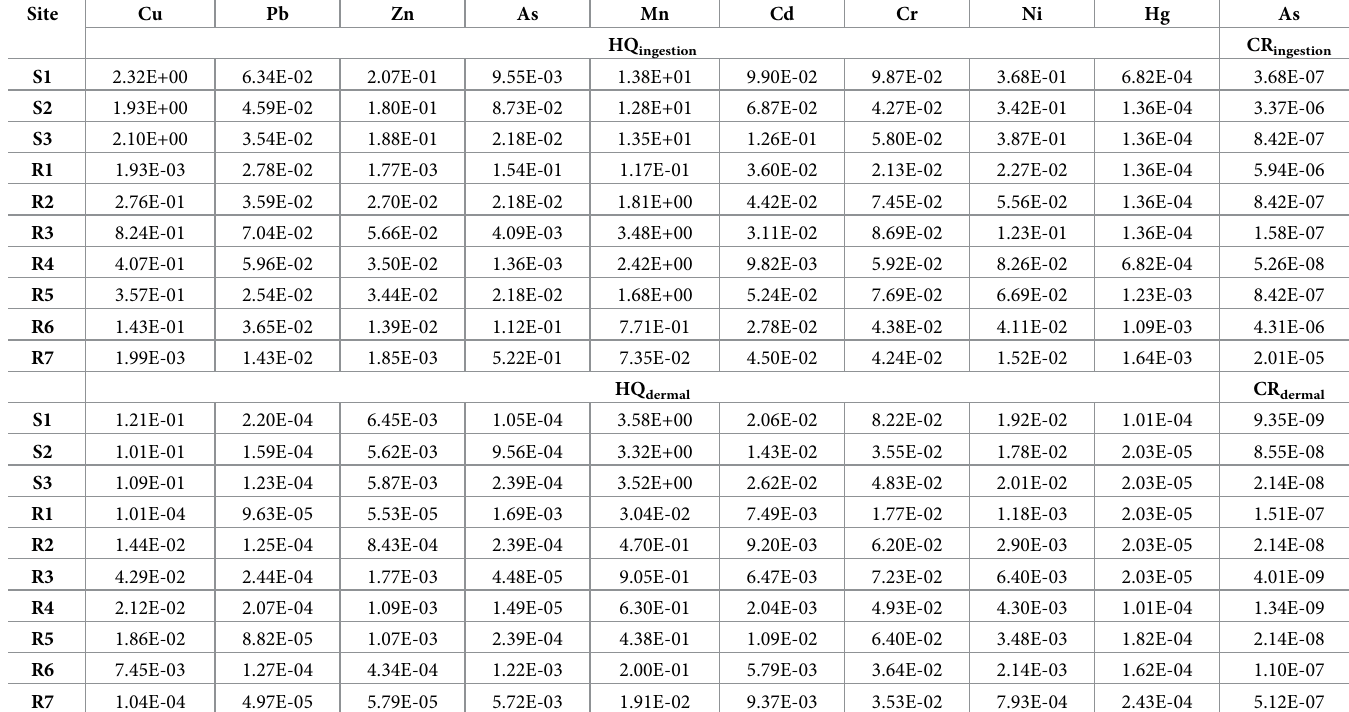
Table 6. Hazard quotient (HQ) and cancer risk (CR) of heavy metals from Rongna River for children.